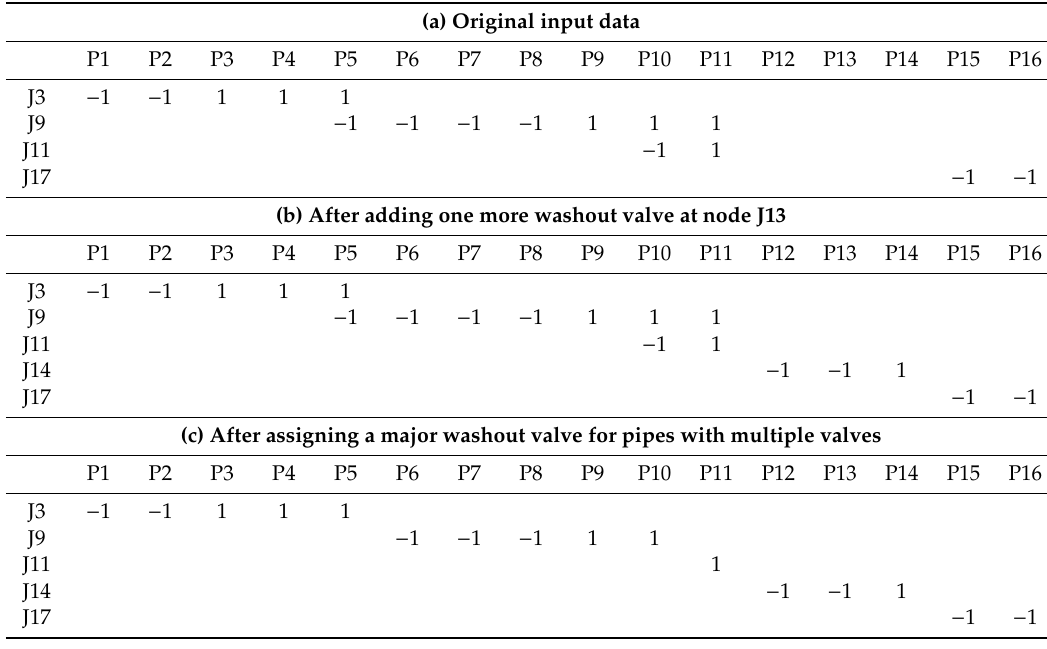
Table 2. Drain direction matrix of a sample